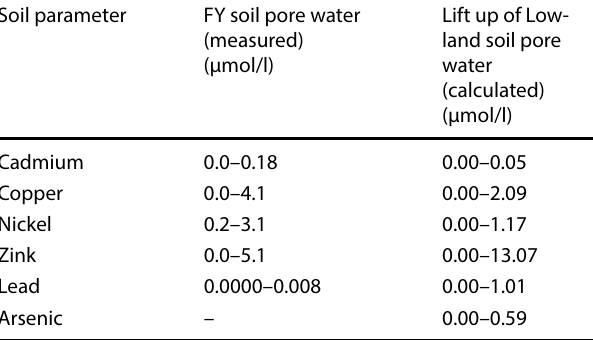
Lift up of Low- land soil